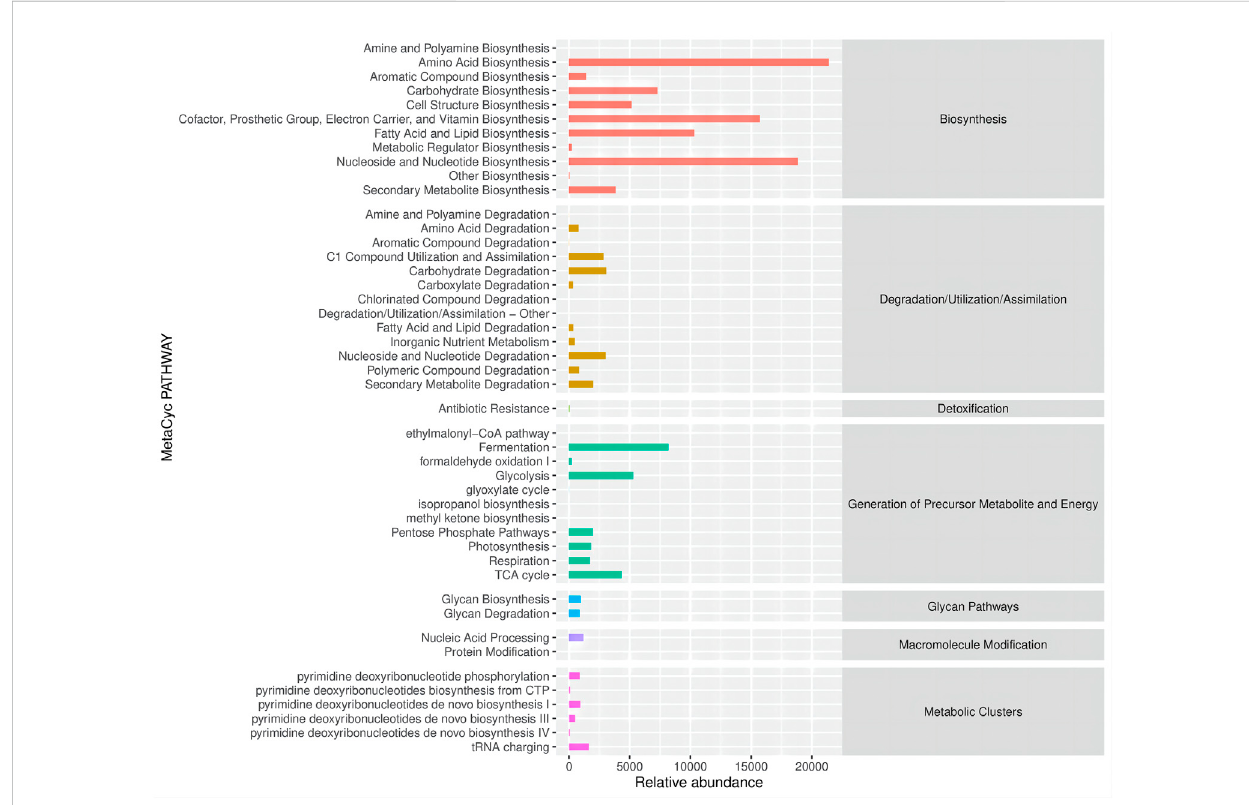
FIGURE 6 Metabolic pathways and relative abundance of differential microbial enrichment in the MetaCyc